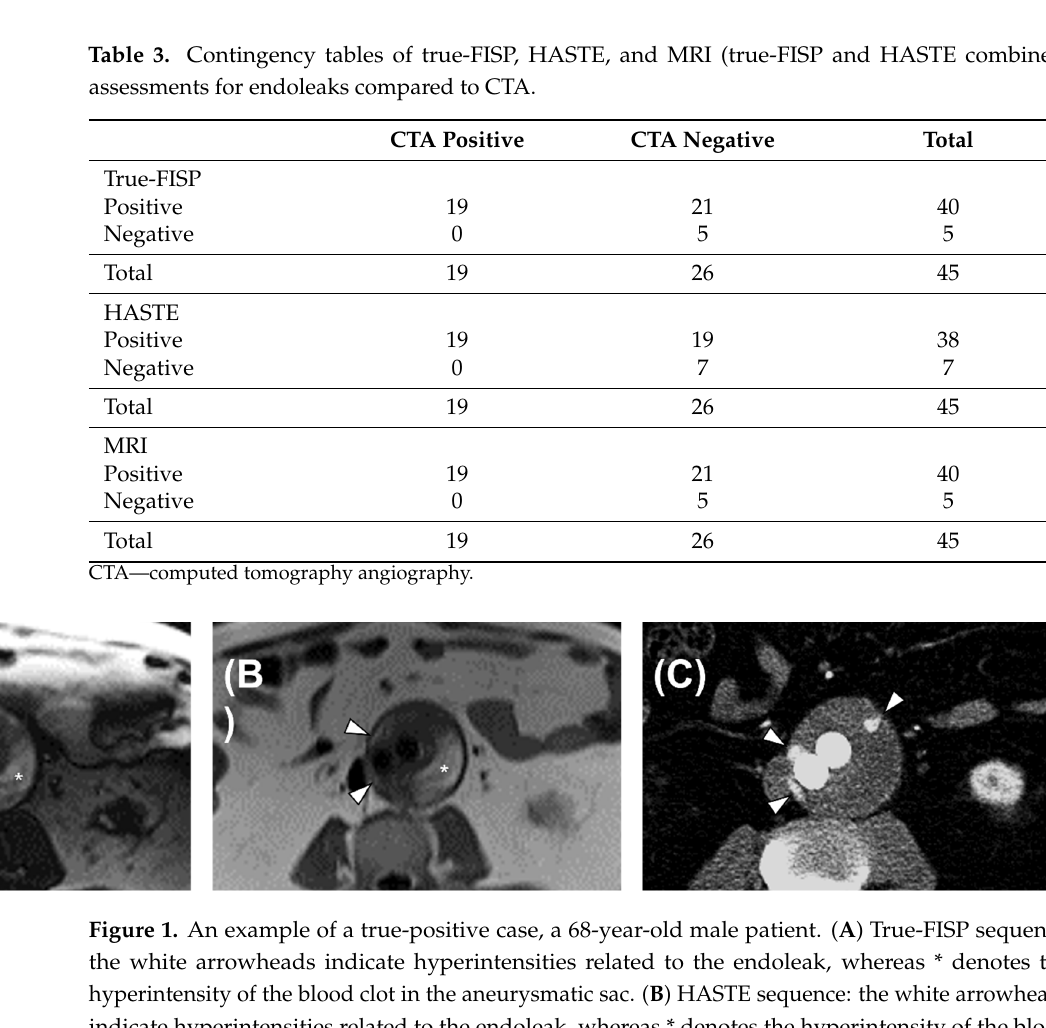
Figure 2. An example of a false ‐ positive case, a 78 ‐ year ‐ old male patient. ( A ) True ‐ FISP sequence: hyperintensity can be observed next to the wall of the endograft (arrowhead). ( B ) HASTE sequence: hyperintensity can be observed next to the wall of the endograft (arrowhead). ( C ) CTA: arterial phase acquisition. A metallic artifact can be observed in correspondence with RM hyperintensities (arrowhead), possibly causing the misinterpretation of the RM images. HASTE sequences were positive in 38 cases, showing 100% sensitivity (95% CI: